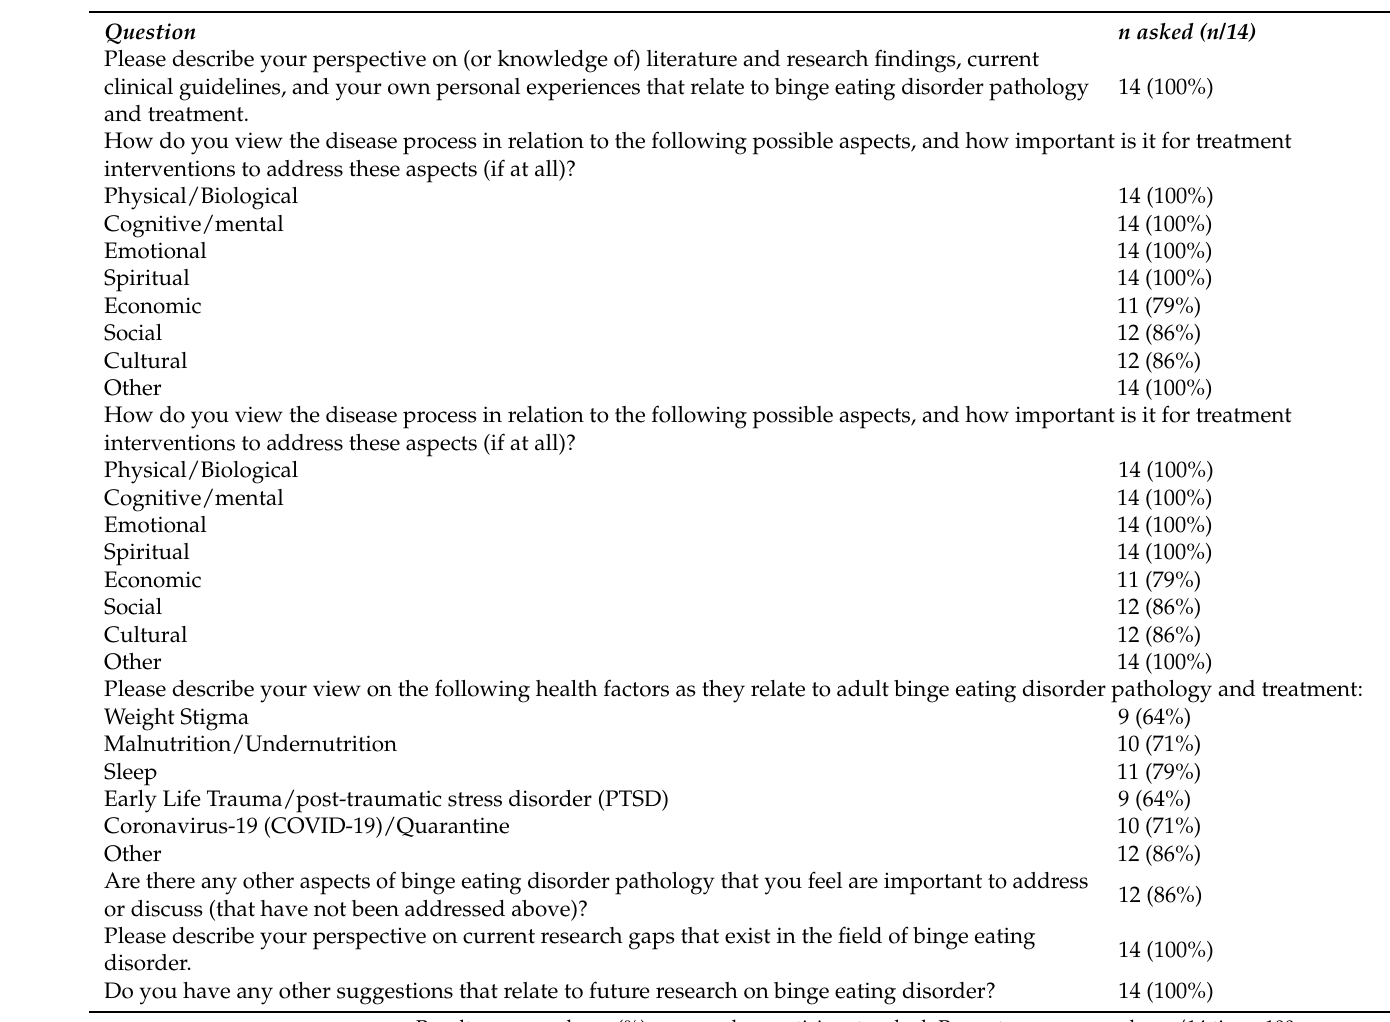
Table 2. Interview questions pertaining to environmental factors relevant to adult binge eating disorder